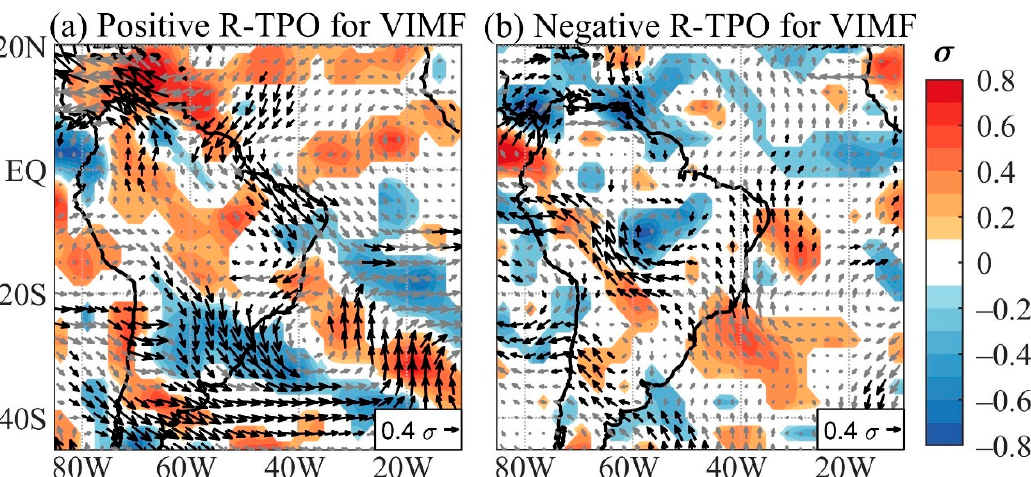
Figure 7. Composites of the anomalies of the residual VIMF components and of their divergence (shades) during austral spring for the: ( a ) positive R-TPO; and ( b ) negative R-TPO. In this Figure, residual means without the IOD effects. Shades encompass significant values at a 95% confidence level using the Student’s t -test. Vectors indicate the VIMF components. The arrow in the right-lower corner gives the vector base magnitude in S.D. units. Bold arrows indicate vectors when at least one component has a significant 95% confidence level value.